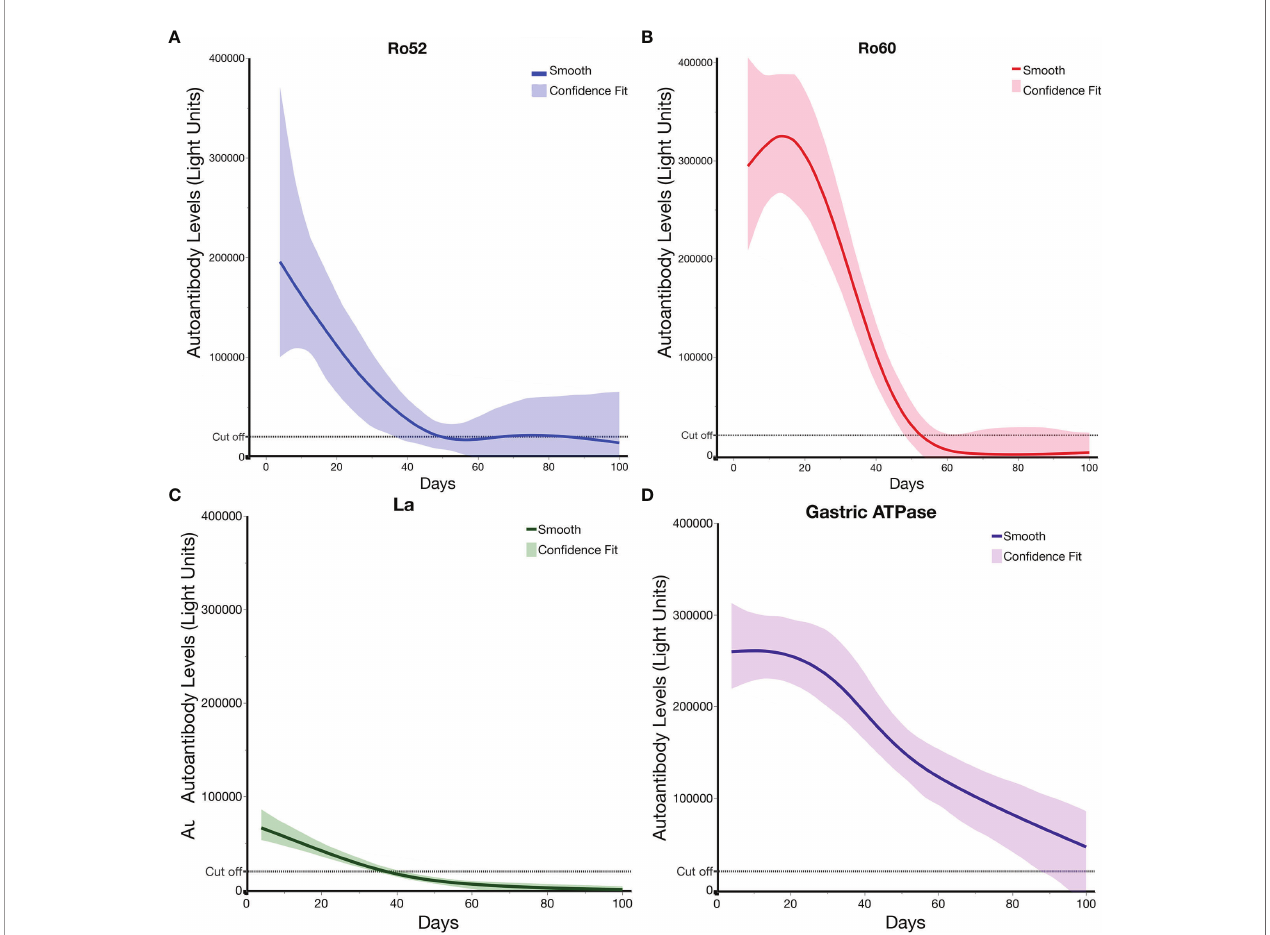
FIGURE 5 | Ro52, Ro60, La, and gastric ATPase autoantibody decay in patients with MIS-C receiving IVIG. Decay plots (A – D) were generated for Ro52, Ro60, La, and gastric ATPase (ATPB4) autoantibody data from the MIS-C (n = 21) patients having two or more different time points. Day 0 is the time the patients received IVIG. The solid-colored line for each autoantigen indicates the decay obtained using JMP ® 14.0.0 and a smoothing spline (cubic spline) with a l of 0.77 with the shaded area representing the bootstrap con fi dence region for each fi t. The dotted lines indicate the cut-off value for determining seronegativity for each